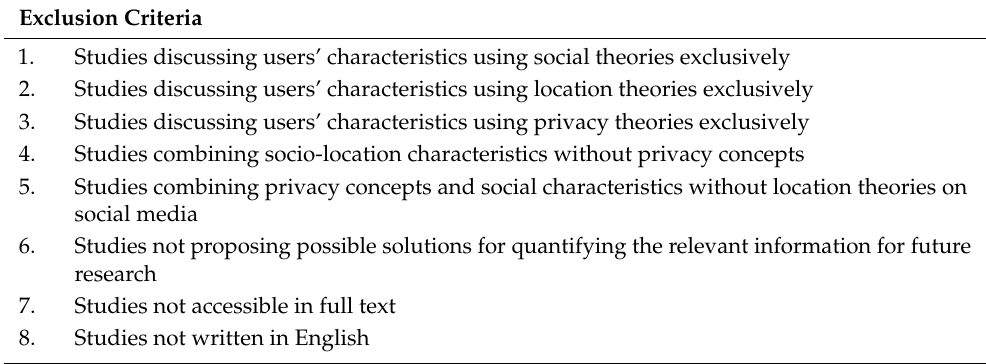
Table 1. Exclusion